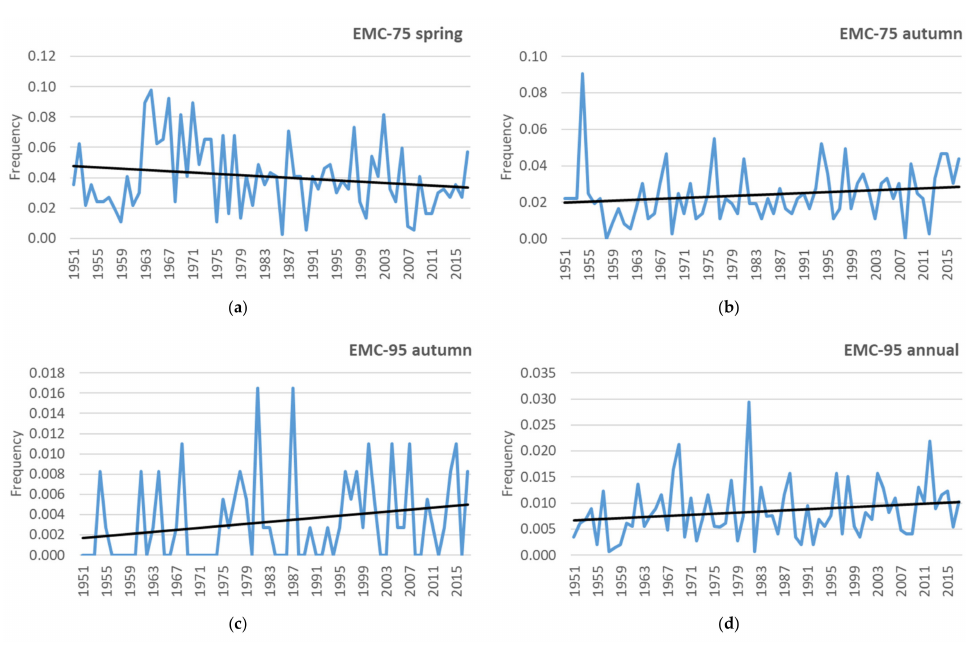
Figure 5. Time plots and linear trends (straight black lines) of standardized anomalies of the frequency of intense/extreme cyclones over the Eastern Mediterranean (EMC-75/EMC-95): ( a ) spring intense cyclones; ( b ) autumn intense cyclones; ( c ) autumn extreme cyclones; ( d ) annual extreme